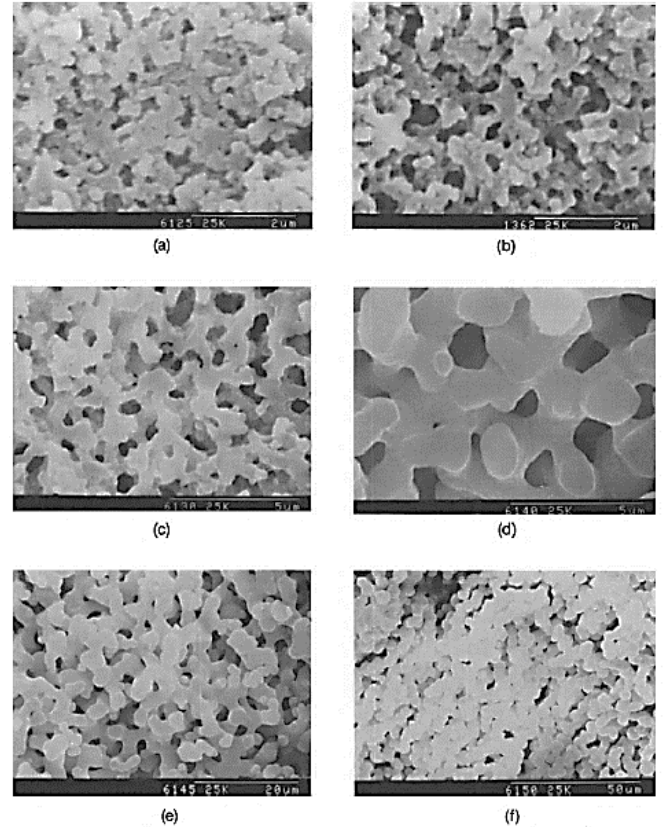
Figure 3. Variations in gel morphology with increasing NaPSS concentration (C, in mol mol − 1 ), at 60 °C for NaPSS Mw between 50,000 and 100,000: ( a ) C = 0.179, scale bar = 2 µm, ( b ) C = 0.187, scale bar = 2 µm, ( c ) C = 0.194, scale bar=5 µm, ( d ) C = 0.201, scale bar=5 µm, ( e ) C = 0.208, scale bar=20 µm, and ( f ) C = 0.215, scale bar = 50 µm. Reprinted with permission from K. Nakanishi and N. Soga, J.